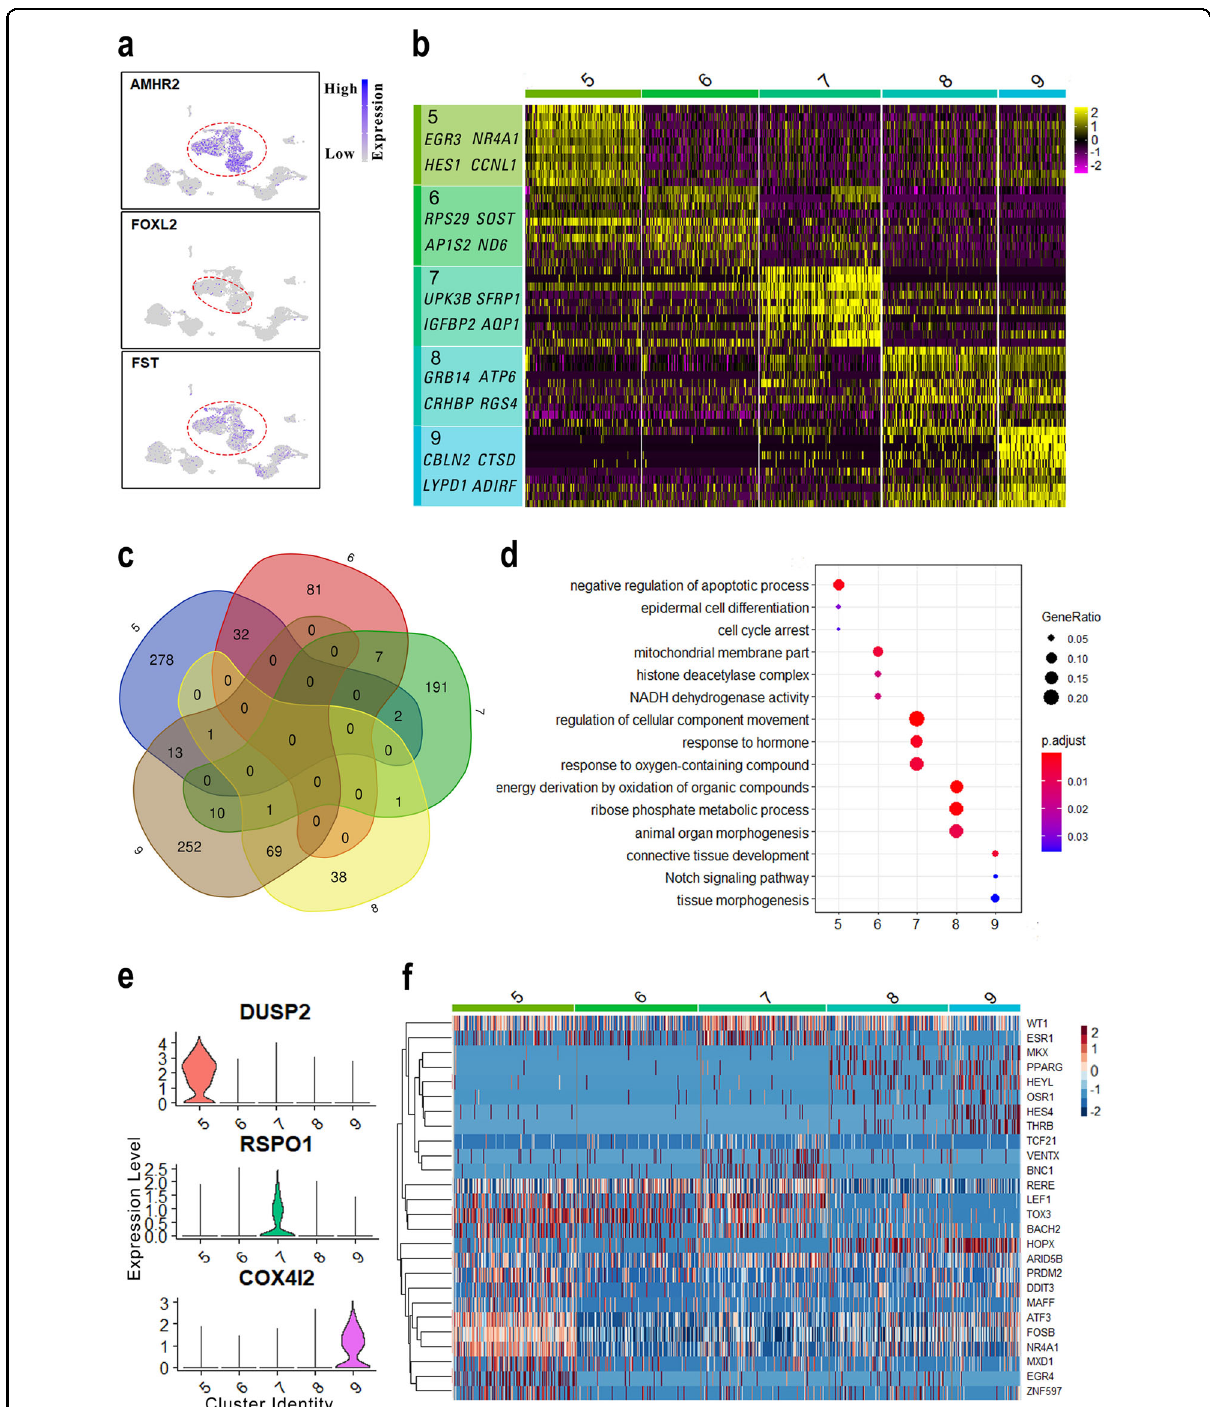
Fig. 5 Dynamic changes of granulosa cell transcriptomes. a The expression of granulosa cell marker genes, with their expression projected onto the UMAP plot. b Heatmap showing representative marker genes of granulosa cell subpopulations (clusters 5 – 9). c Venn diagram shows overlapping of differentially expressed genes among granulosa cell populations. d The enriched GO terms (biological processes) to the subpopulations of the granulosa cells (clusters 5 – 9). e Violin plots show the speci fi c expressed genes in different granulosa cell subpopulations. f Heatmap representing the dynamics of transcription factors across granulosa cell